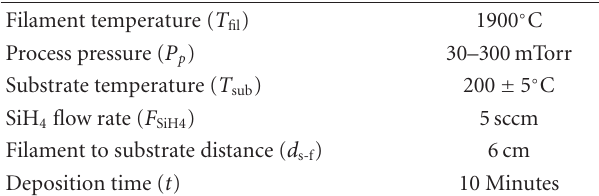
Table 1: Deposition parameters employed for synthesis of Si:H films by hot wire